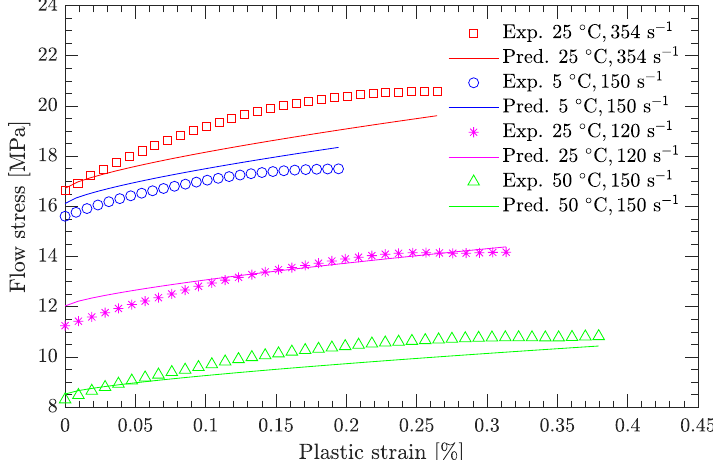
Figure 16. Comparison of predicted and measured flow stresses under dynamic compression.